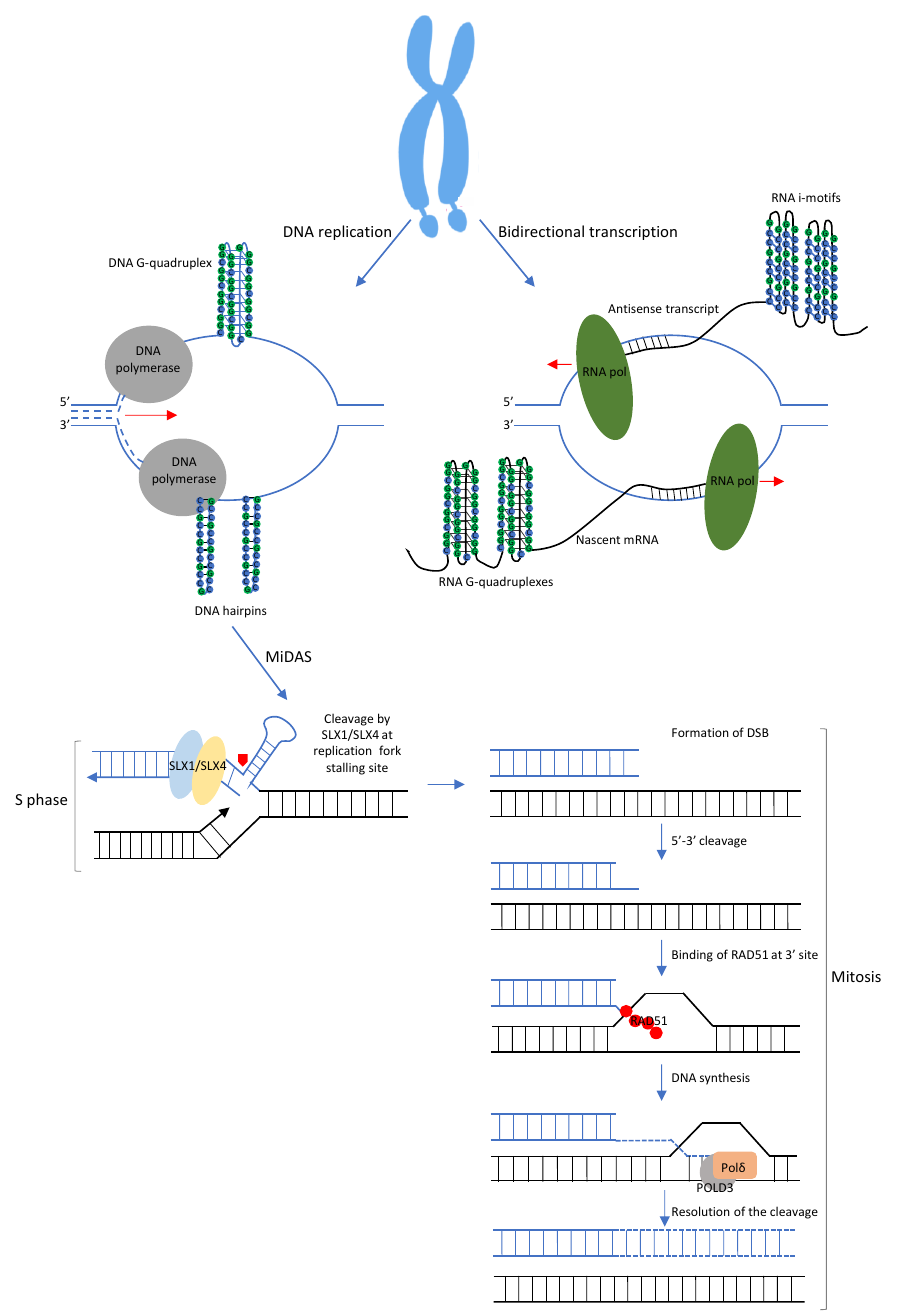
Figure 2. Secondary structures forming at the FRAXA site and their role during DNA synthesis in mitosis (MiDAS). During DNA replication at the FRAXA site, two different secondary structures may form in the CGG repeat sequence: G quadruplex structures on the leading strand and hairpins on the lagging strand. During DNA bidirectional transcription, both nascent RNAs may assume anomalous conformations: the FMR1 -mRNA, that is G-rich, is able to form G-quadruplexes, contrariwise the antisense transcript, C-rich, prefers i-motifs. The formation of several secondary structures at the expanded CGG sequence cause failure to complete MiDAS at FRAXA locus. MiDAS starts during S phase of cell cycle with the stalling of DNA polymerase during replication due to the presence of such secondary structures. Endonucleases SLX1/SLX4 induce the formation of a DSB to remove the anomalous structures. The break will be solved during mitosis by the RAD51 recombinase, that binds 3 (cid:48) end of the cleaved DNA strand and brings it near to the homologous template to complete DNA synthesis via POLD3/Pol δ